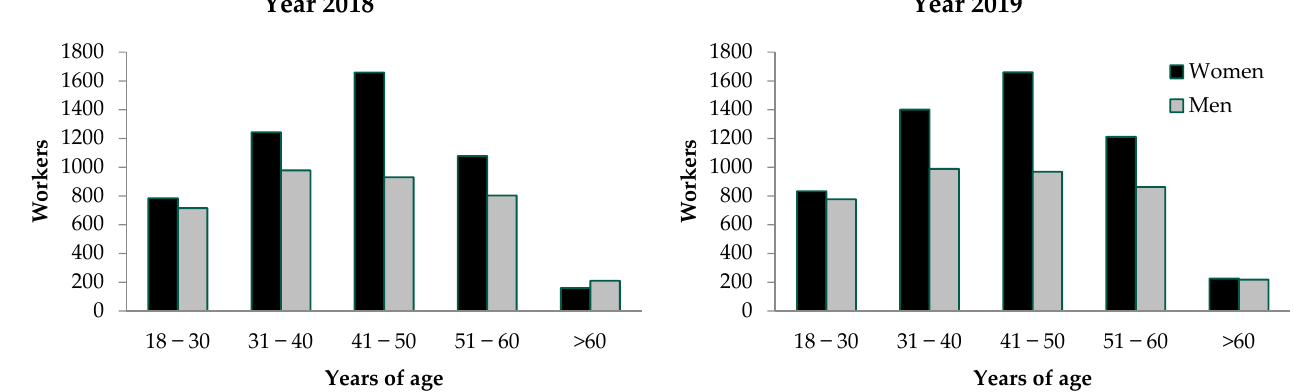
Figure 1. Absolute number of workers who required sick leave due to ear diagnoses during years 2018 and 2019, by age group, sex and year (either 2018 or 2019).